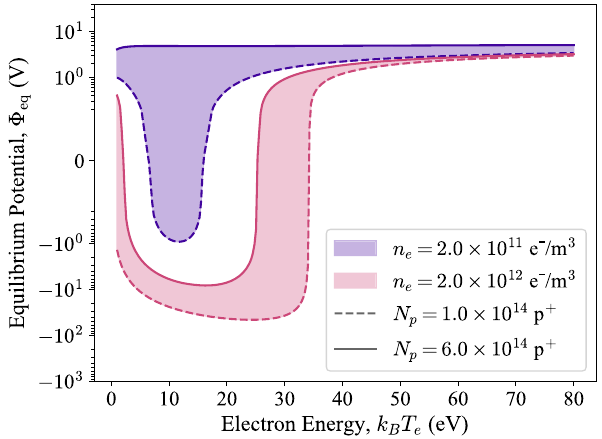
FIG. 4. Equilibrium potential of a Cu grain for beam intensities ranging from 1 × 10 14 p þ to 6 × 10 14 p þ , as a function of the energy of the incoming electrons. The results are shown for two- electron cloud densities. The collection and secondary electron currents increase with n , whereas the photoelectric current e increases with N . p